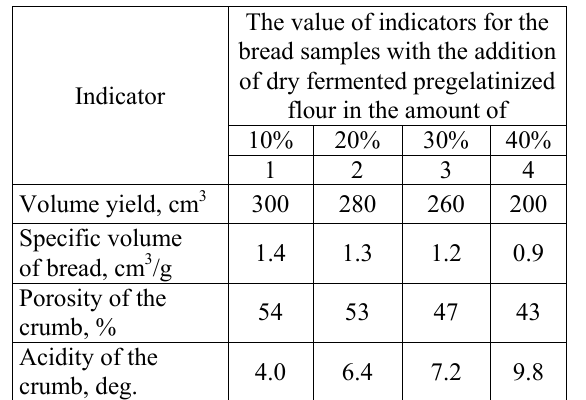
Table 4 . Effect of dry fermented pregelatinized